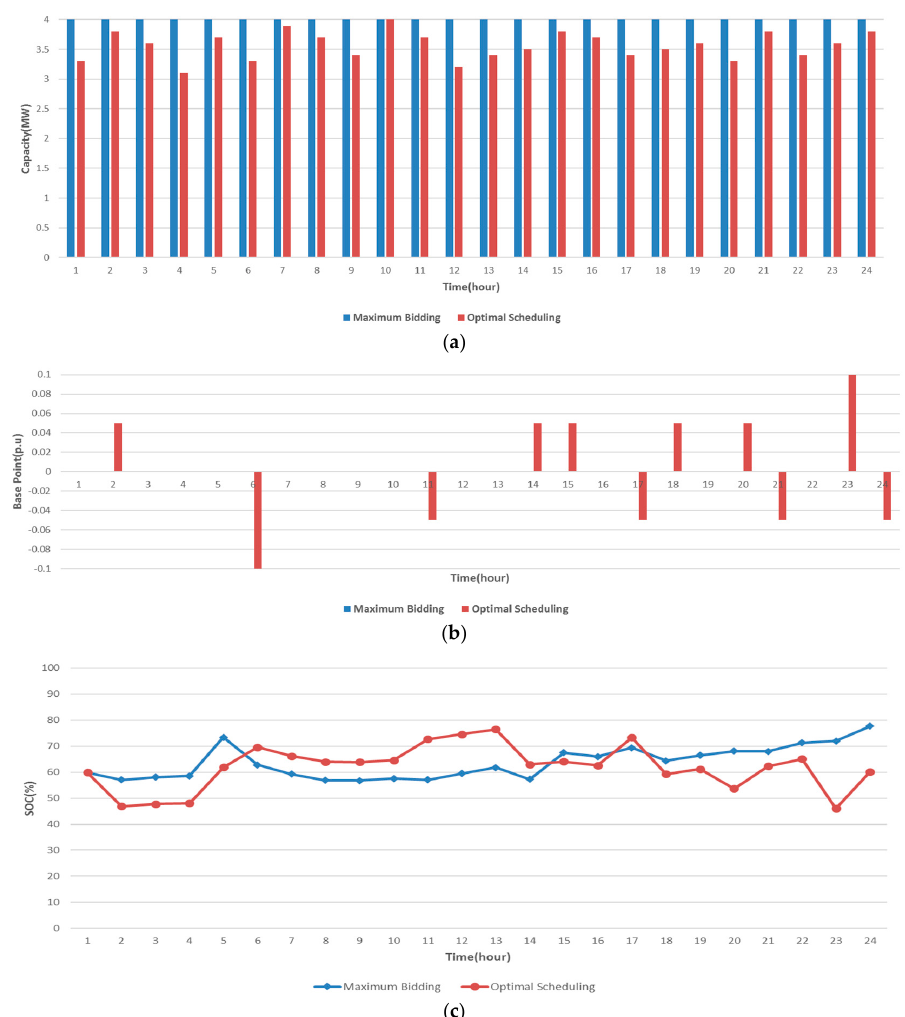
Figure 3. Maximum capacity bidding plan and optimal scheduling algorithm results ( a ) bidding capacity; ( b ) base point; and ( c ) SOC . Table 1. Frequency regulation scheduling profits.